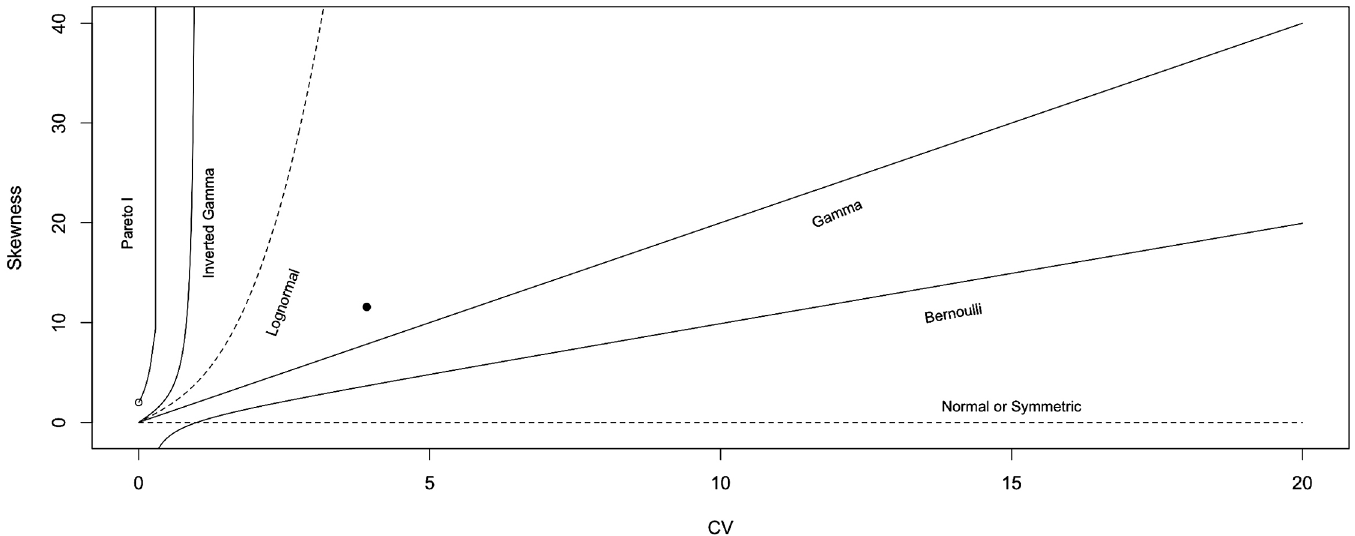
Fig 6. Discriminant Moment-ratio Plot. Discriminant moment-ratio plot for the non-zero payments, all claims pooled together. The large dot represents the pair “ CV and Skewness ” and it falls in the so-called lognormal region.